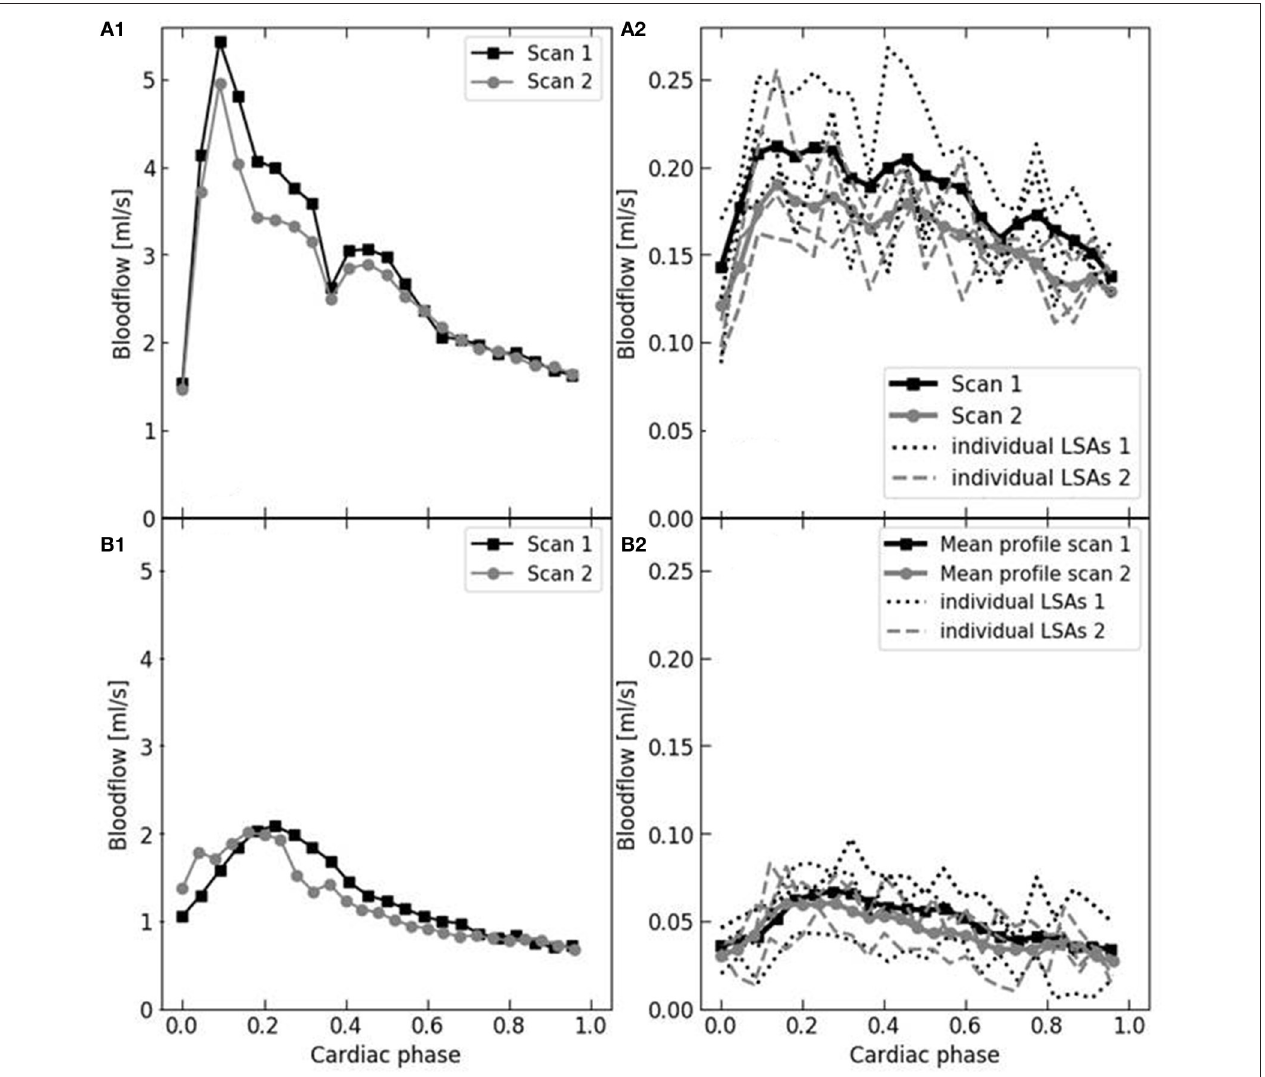
FIGURE 2 | Example flow waveforms in the MCA (left: A1,B1 ) and LSA (right: A2,B2 ) and of a young (upper: A1,A2 ) and older (bottom: B1,B2 ) subject. The two subsequent reproducibility measurements are depicted (black squares and gray circles, respectively). The waveform of the MCA was derived from one vessel and, for the LSA, it was averaged over multiple vessels (three in these cases). Note that the MCA waveform of the older subject is lower and less sharp.